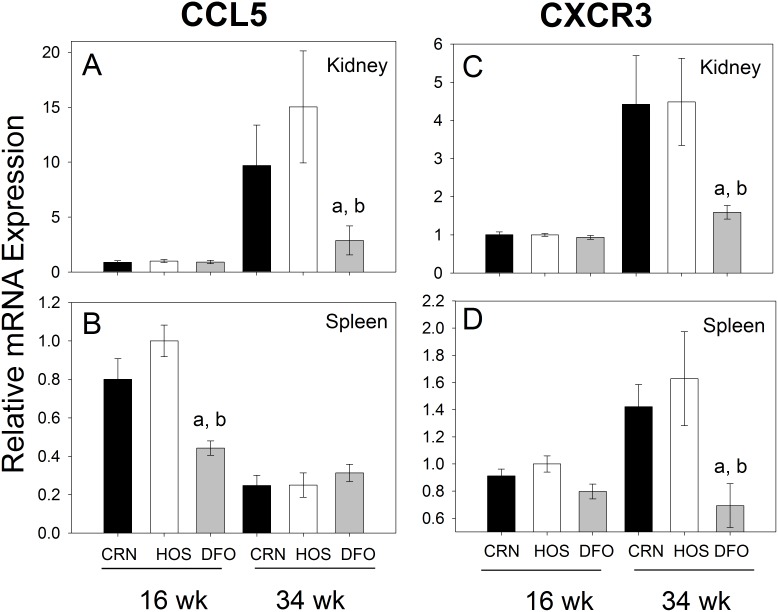
Differential effects of n-3, n-6 and n-9 PUFA consumption on CCL5 and CXCR3 mRNA expression.Experiment conducted as described in Fig. 7 legend except that CCL5 (A, B) and CXCR3 (C, D) mRNAs were measured by quantitative RT-PCR.